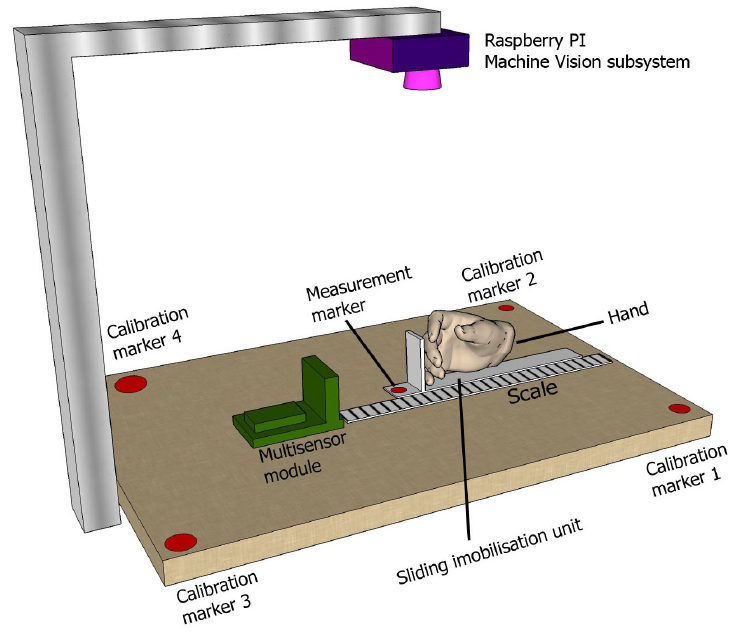
Figure 5. Illustration of the measurement setup.